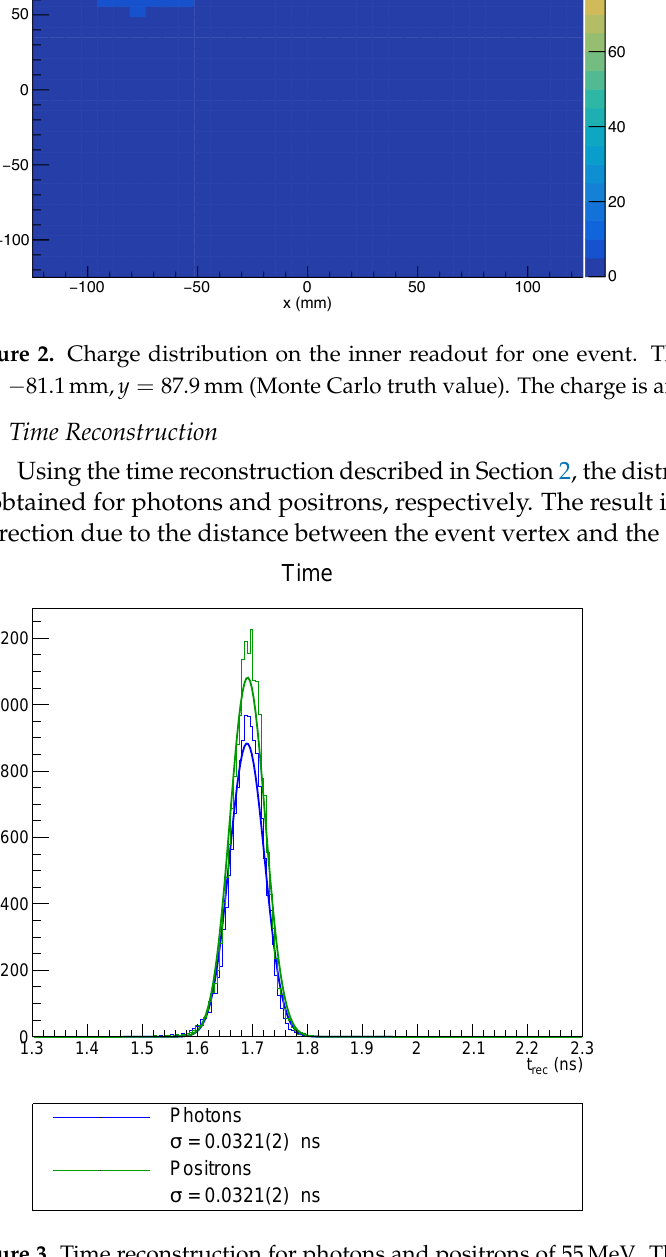
Figure 3. Time reconstruction for photons and positrons of 55MeV. The correction accounting for the particle time of flight is applied. The resolution σ is obtained from a Gaussian